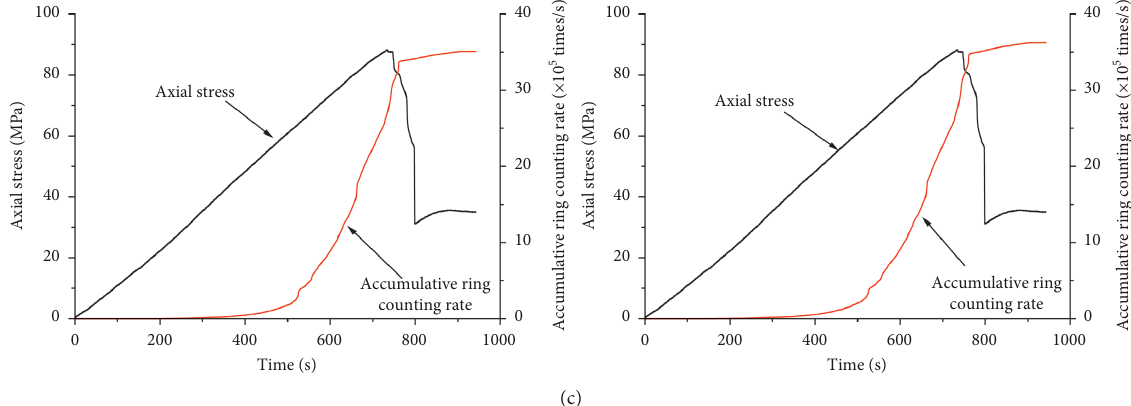
Figure 16: AE parameter curves of limestone with AE detector outside and inside the triaxial chamber, respectively: (a) AE ringing count; (b) AE energy; (c) accumulative ringing